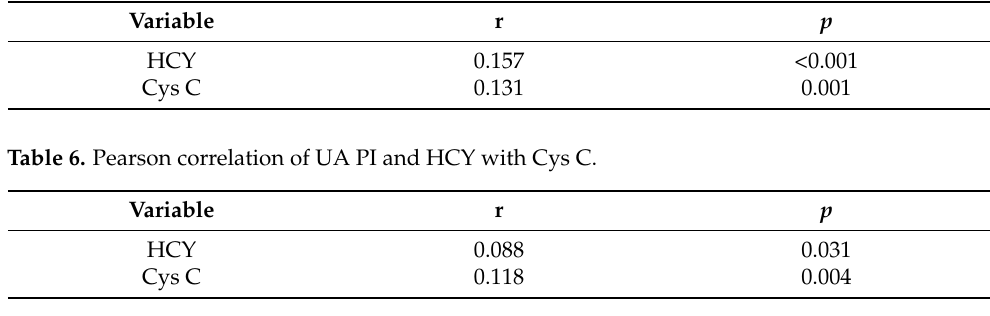
Table 5. Pearson correlation of UA S/D with HCY and Cys C.